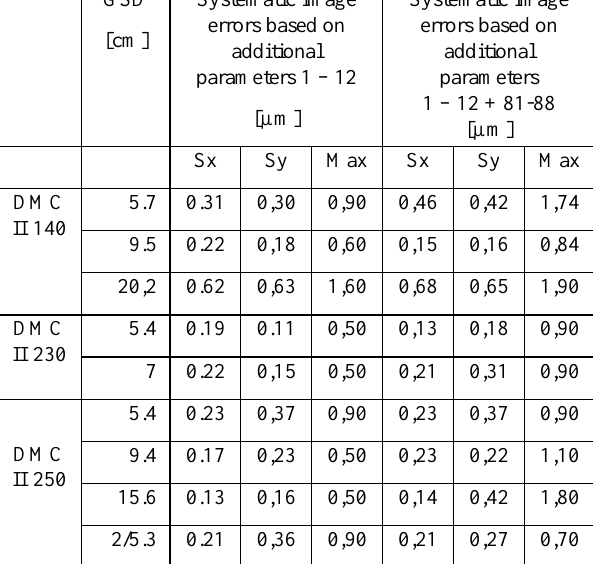
Systematic image errors based on